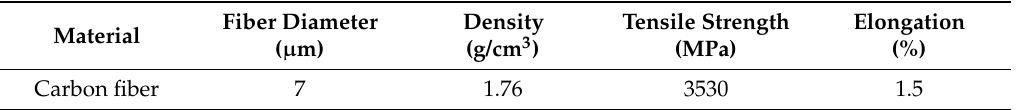
Table 1. Material properties of carbon fiber.